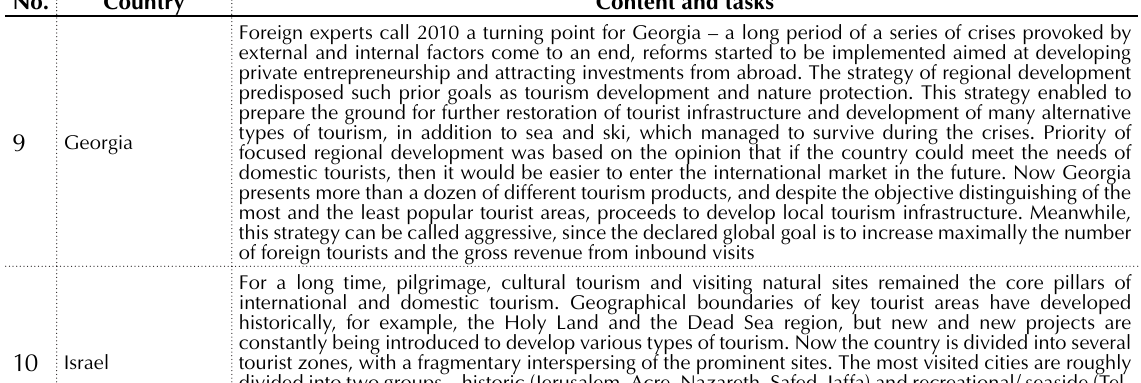
Table B1 (cont). The content of state programmes and investment proposals (mentioned in Table 5 of the main text) No. Content and